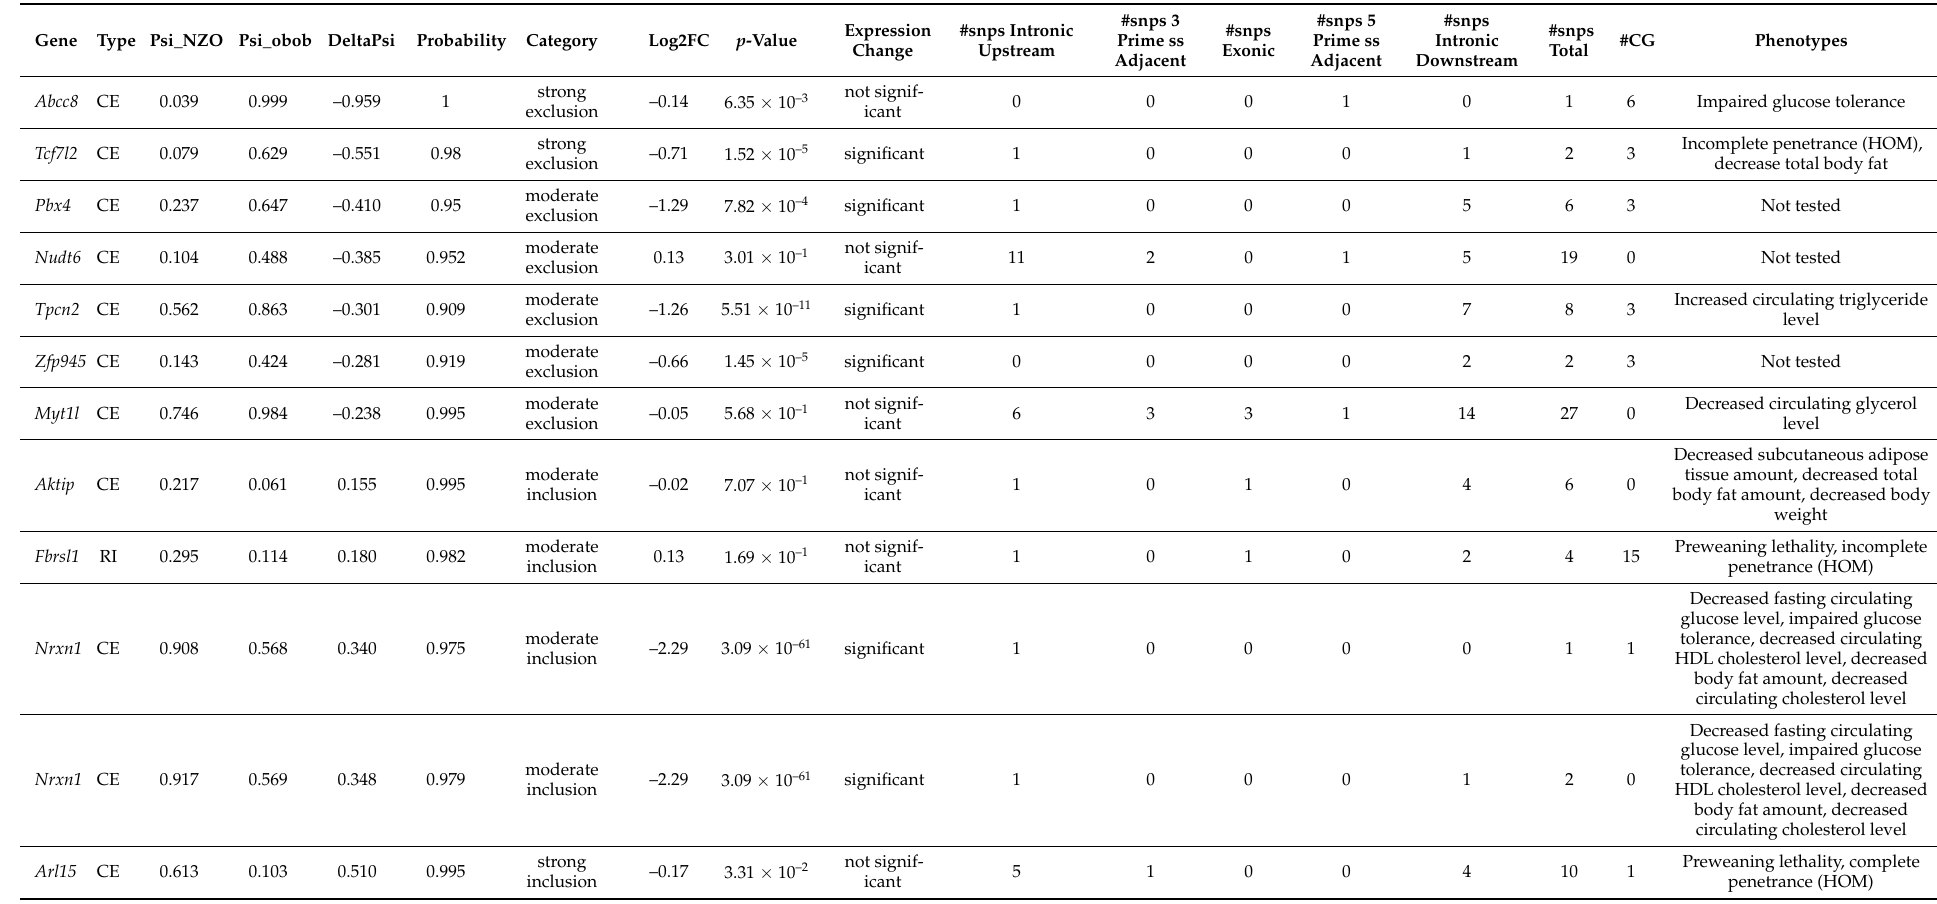
Table 1. In silico analysis of genes with differential splicing events in NZO islet and described in T2D GWAS